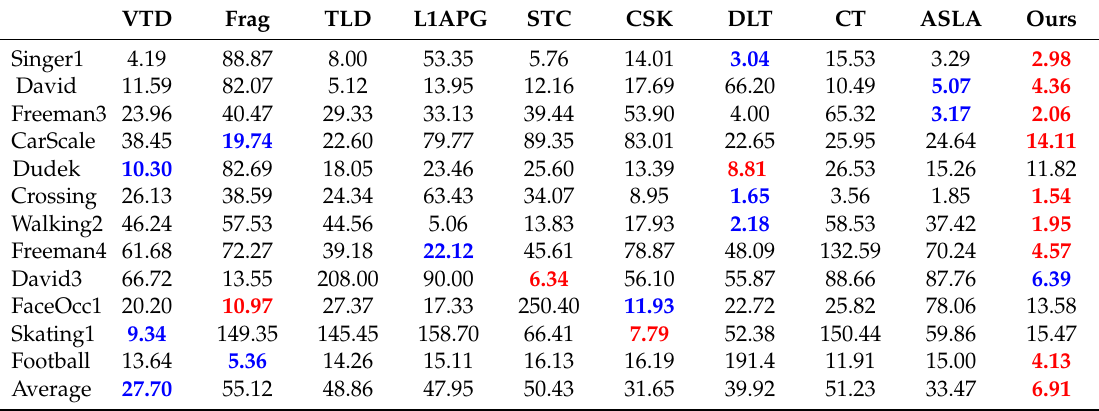
Table 1. Average center error (in pixels). The best two results are shown in bold red and blue